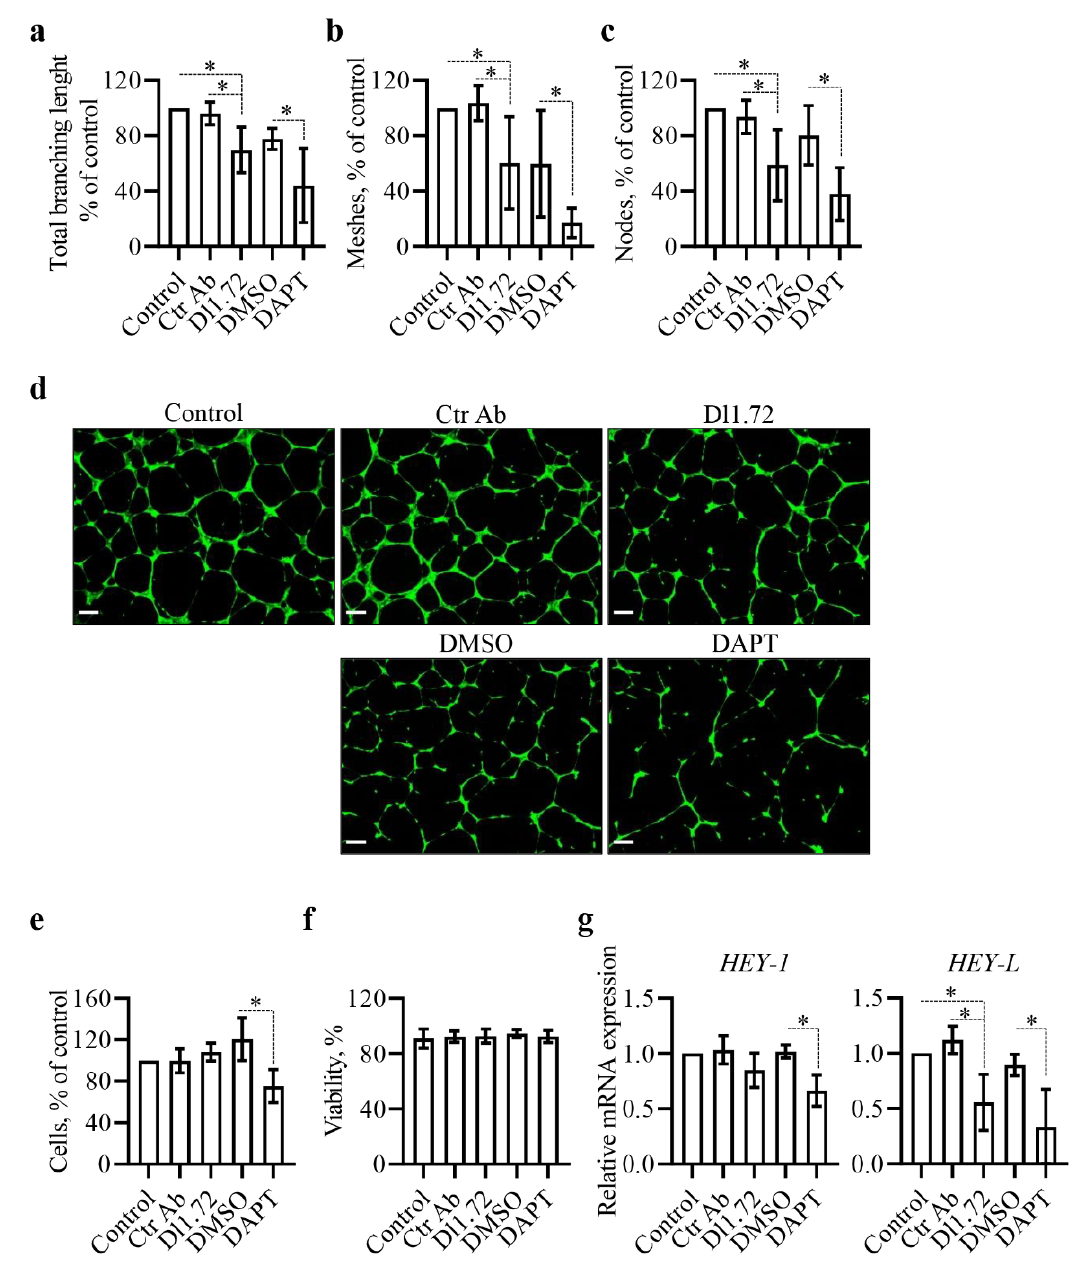
Figure 4. Anti-DLL1 Dl1.72 impairs the angiogenic potential of HUVEC cells. HUVEC cells were cultured in the absence (control) or presence of Dl1.72, Ctr Ab (10 µ g/mL each), DAPT or DMSO for 70–76 h until 80% confluence, collected and plated on matrigel or geltrex to evaluate ( a – d ) HUVEC tube-network forming ability performance. The graphs in ( a – c ) show mean percentage values ( ± SD, n = 6) of total branching length, meshes/cavities, and nodes. ( d ) Representative images of calcein-stained cells. Scale bars, 200 µ m. Mean percentage of ( e ) cells and ( f ) viability relative to control untreated cells ( ± SD) from five independent assays performed as described above. ( g ) Gene expression profile of Notch-target genes HEY-1 and HEY-L in HUVEC cells treated as above was determined by RT-qPCR. Graphs show mean mRNA fold change relative to control cells ( ± SD, n = 4). *, p < 0.05 (two-tailed paired Student t -test).